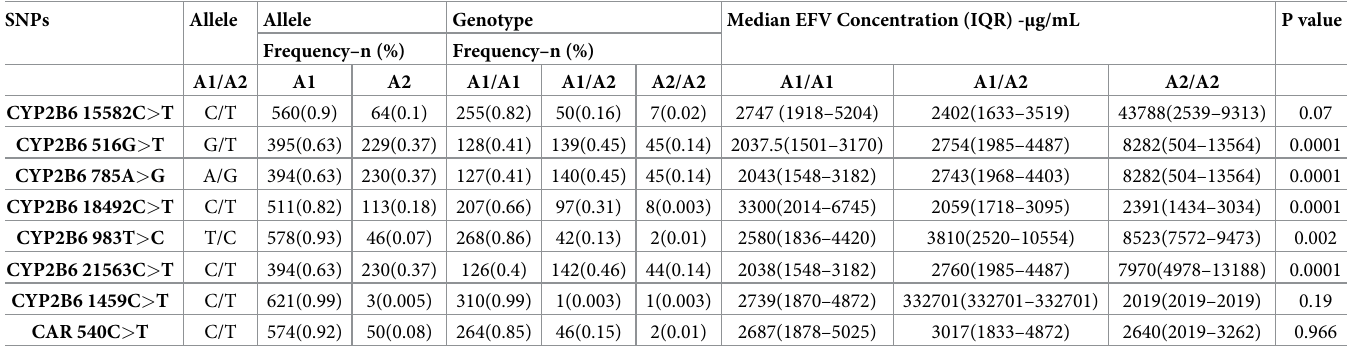
Table 3. Allele and genotype frequencies of CYP2B6 gene and CAR SNPs and their relationship with EFV plasma concentrations. SNPs